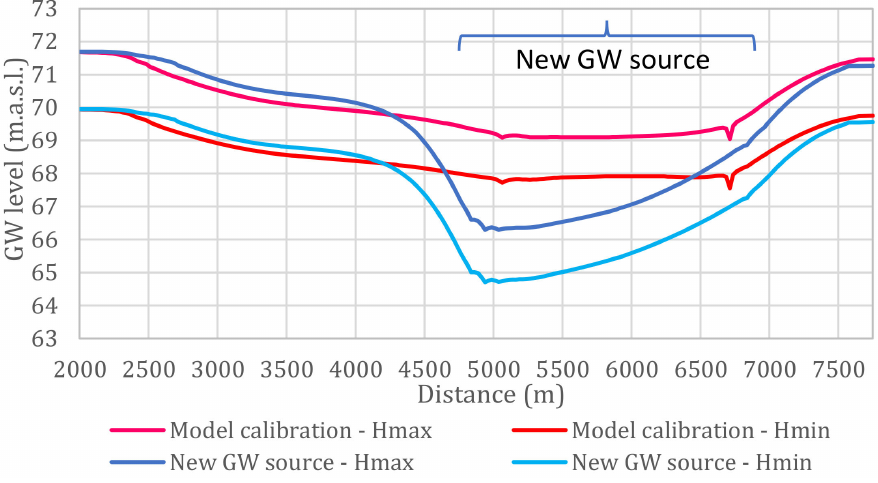
Figure 13. Groundwater level variations depending on the hydrology of the Danube before and after pumping wells become operational along the line shown in Figure 1.